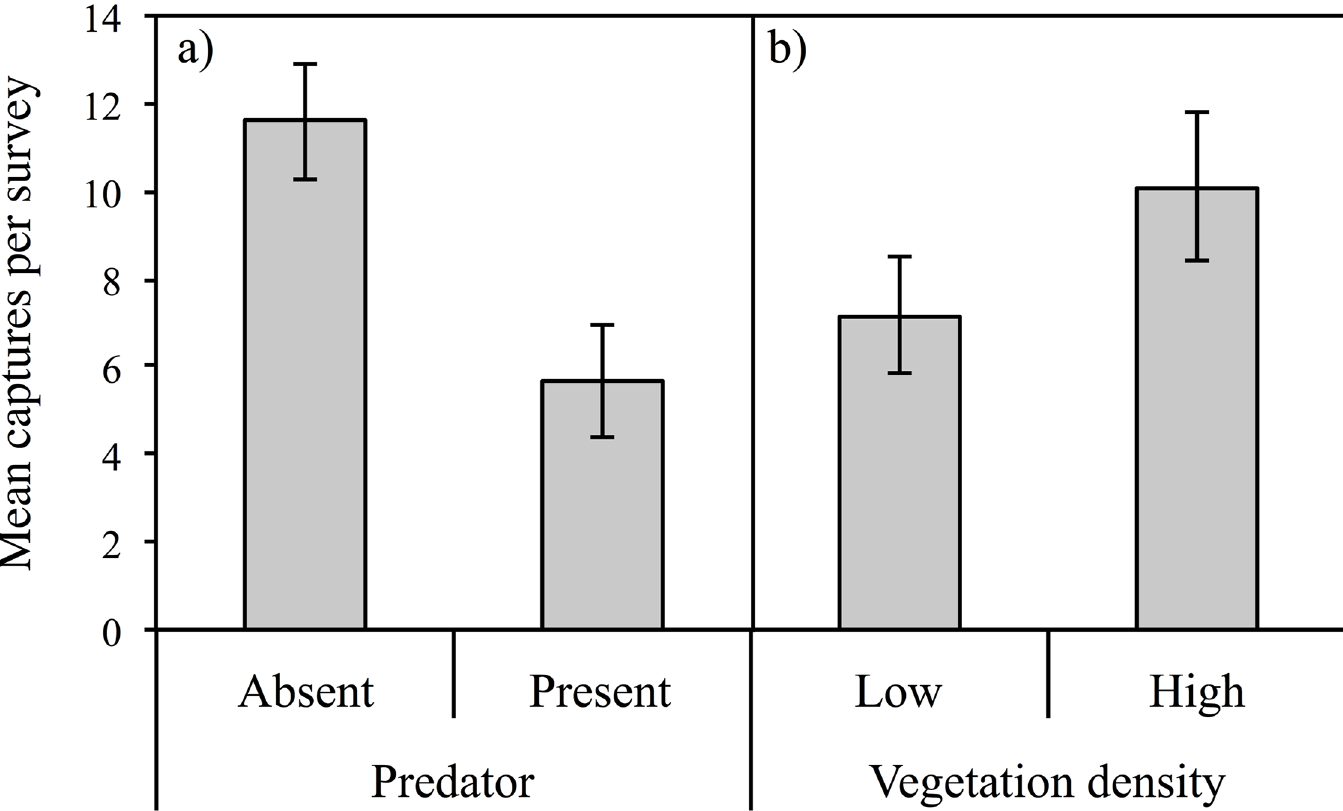
Fig 2. Mean number of tadpoles captured per survey for predator presence (a) and vegetation density (b), ± 1 SE. The maximum possible catch per treatment is n =